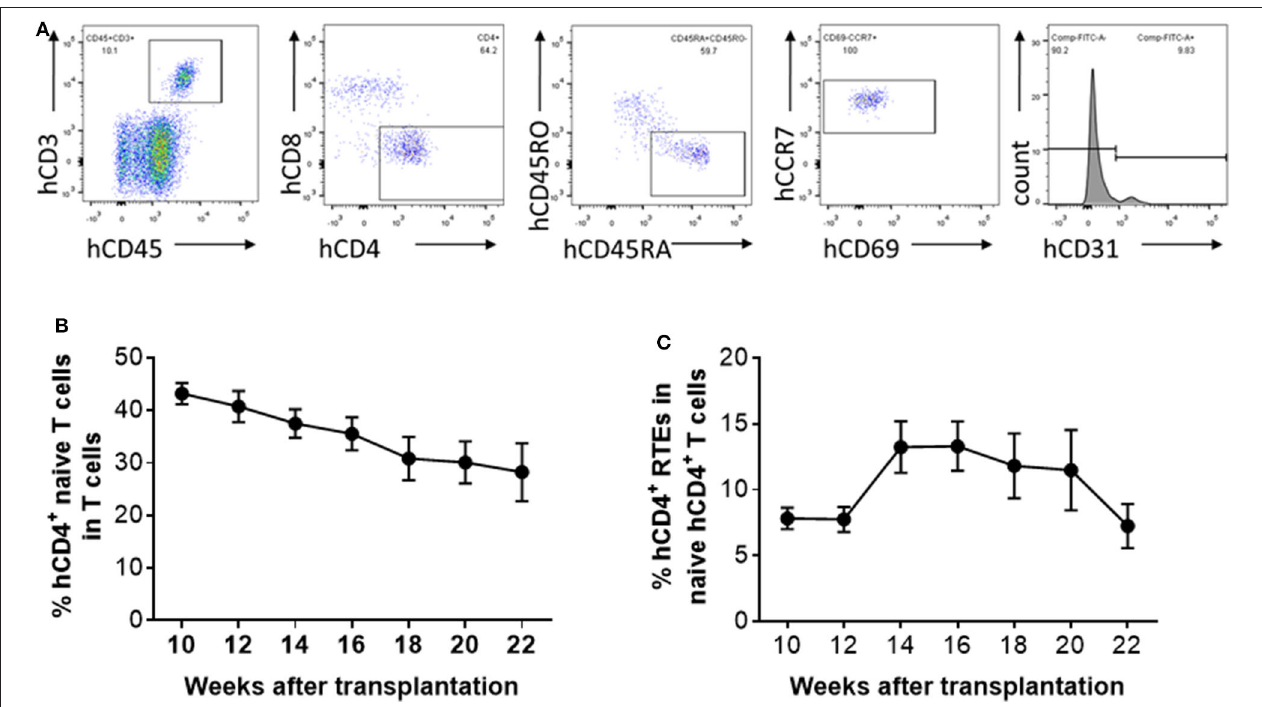
FIGURE 2 | Kinetic changes in human CD4 + naïve T cells and RTEs in hu-mice. (A) Representative FCM profiles. (B,C) Percentages of CD4 + CD45RA + CD45RO − naïve T cells (B) and CD4 + CD45RA + CD45RO − CD31 + RTEs (C) in PBMCs at the indicated times ( n = 5–28 animals were analyzed at each time point).